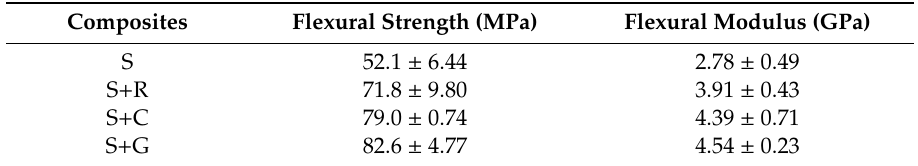
Table 3. Flexural test